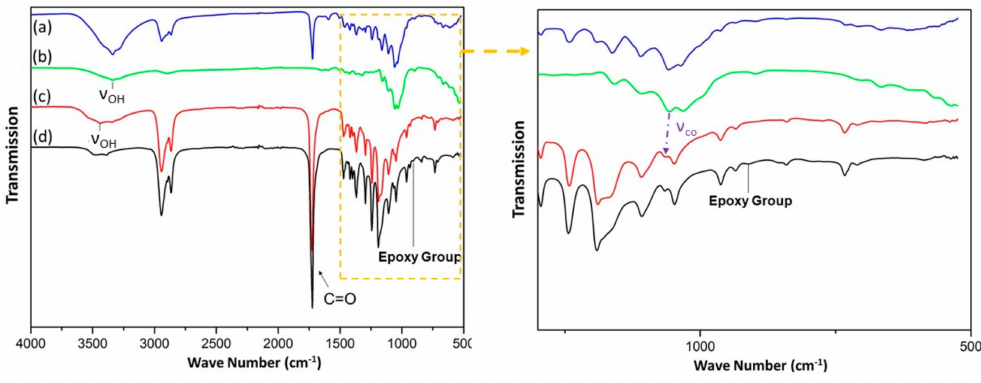
Figure 6. FTIR Spectra: (a) Natural wood; (b) lignin-removed wood(LRW); (c) shape memory wood(SMW); (d) PCL & epoxy-POSS mixture